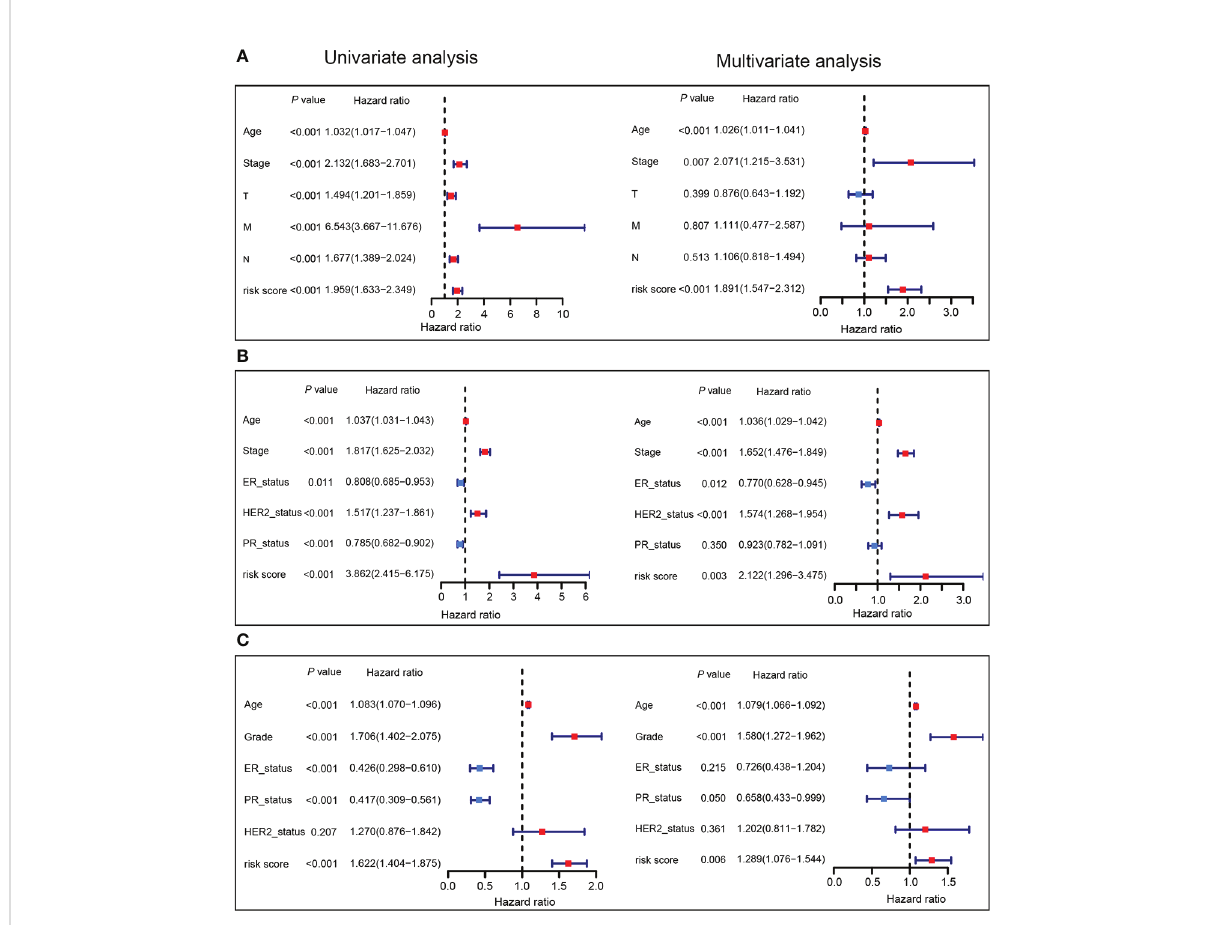
FIGURE 5 The prognostic values of PTS risk score in breast cancer. Univariate and multivariate Cox regression analyses of the PTS risk score in the TCGA training dataset (A) , METABRIC validation dataset (B) , and GSE96058 validation dataset (C) regarding